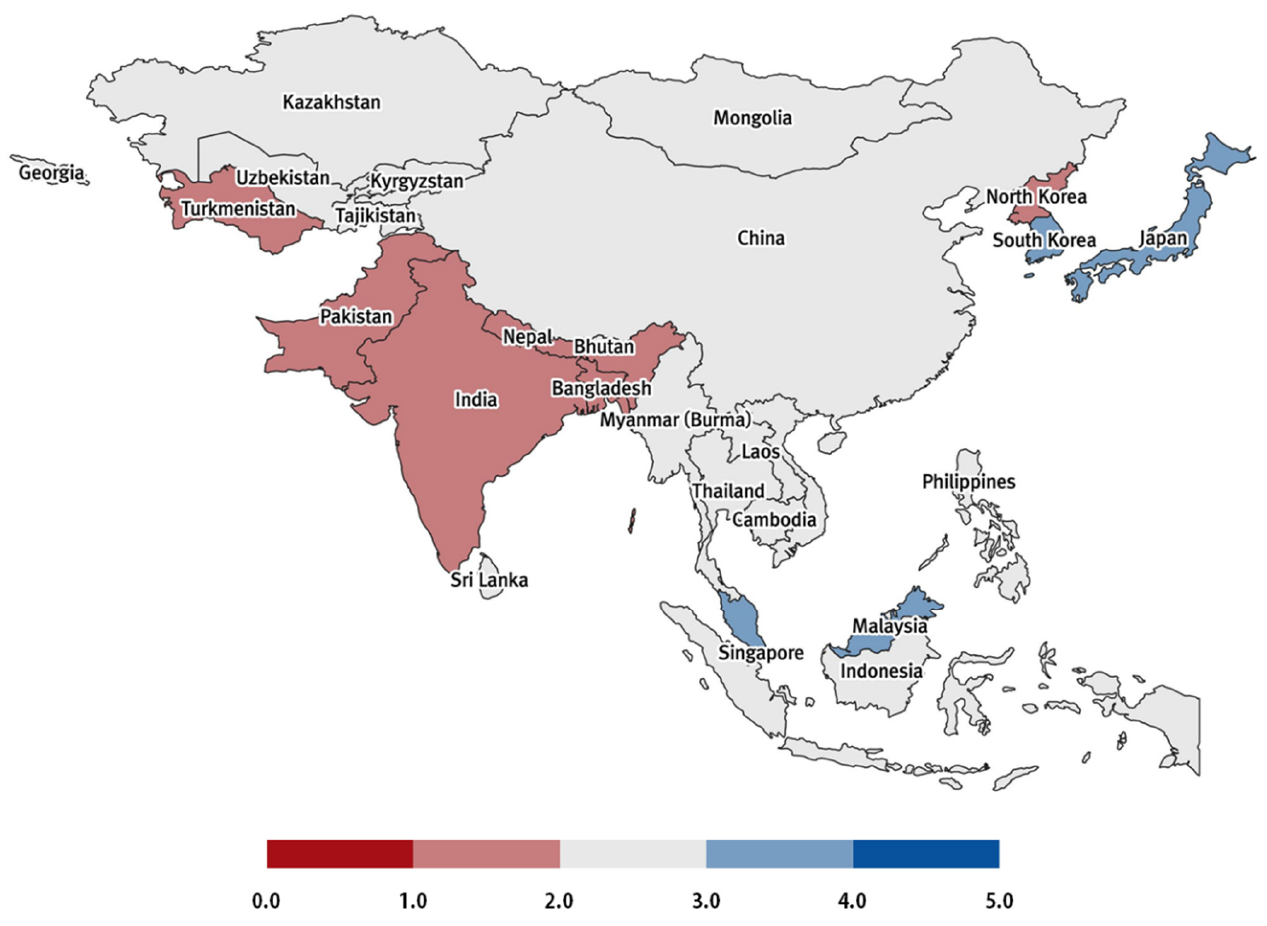
Figure 2. Water Security Index (WSI) results in Asia. Table 12. Assessment results of Water Security Index